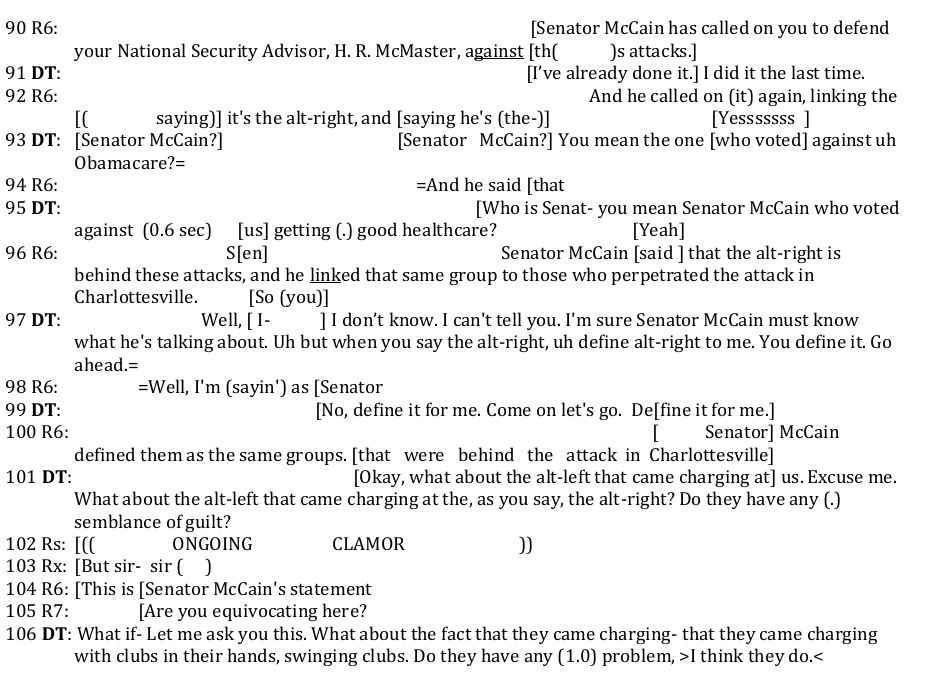
Figure 10. Transcript excerpt 90–106.